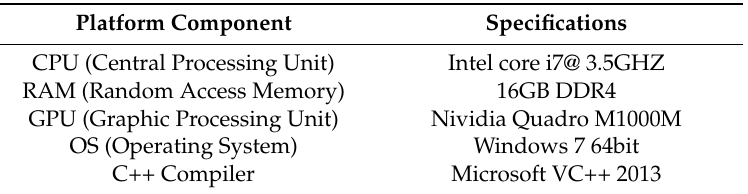
Table 4. Platform specification of the run-time